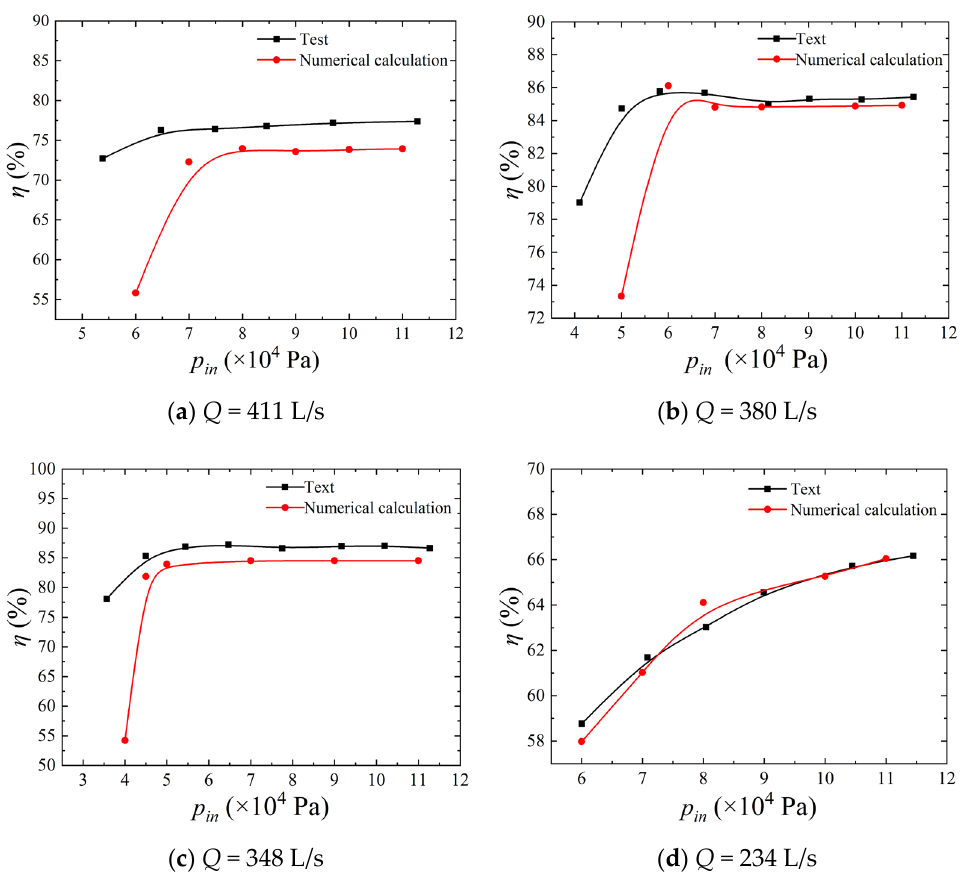
Figure 7. Comparison of the numerical calculation and the test cavitation performance results.